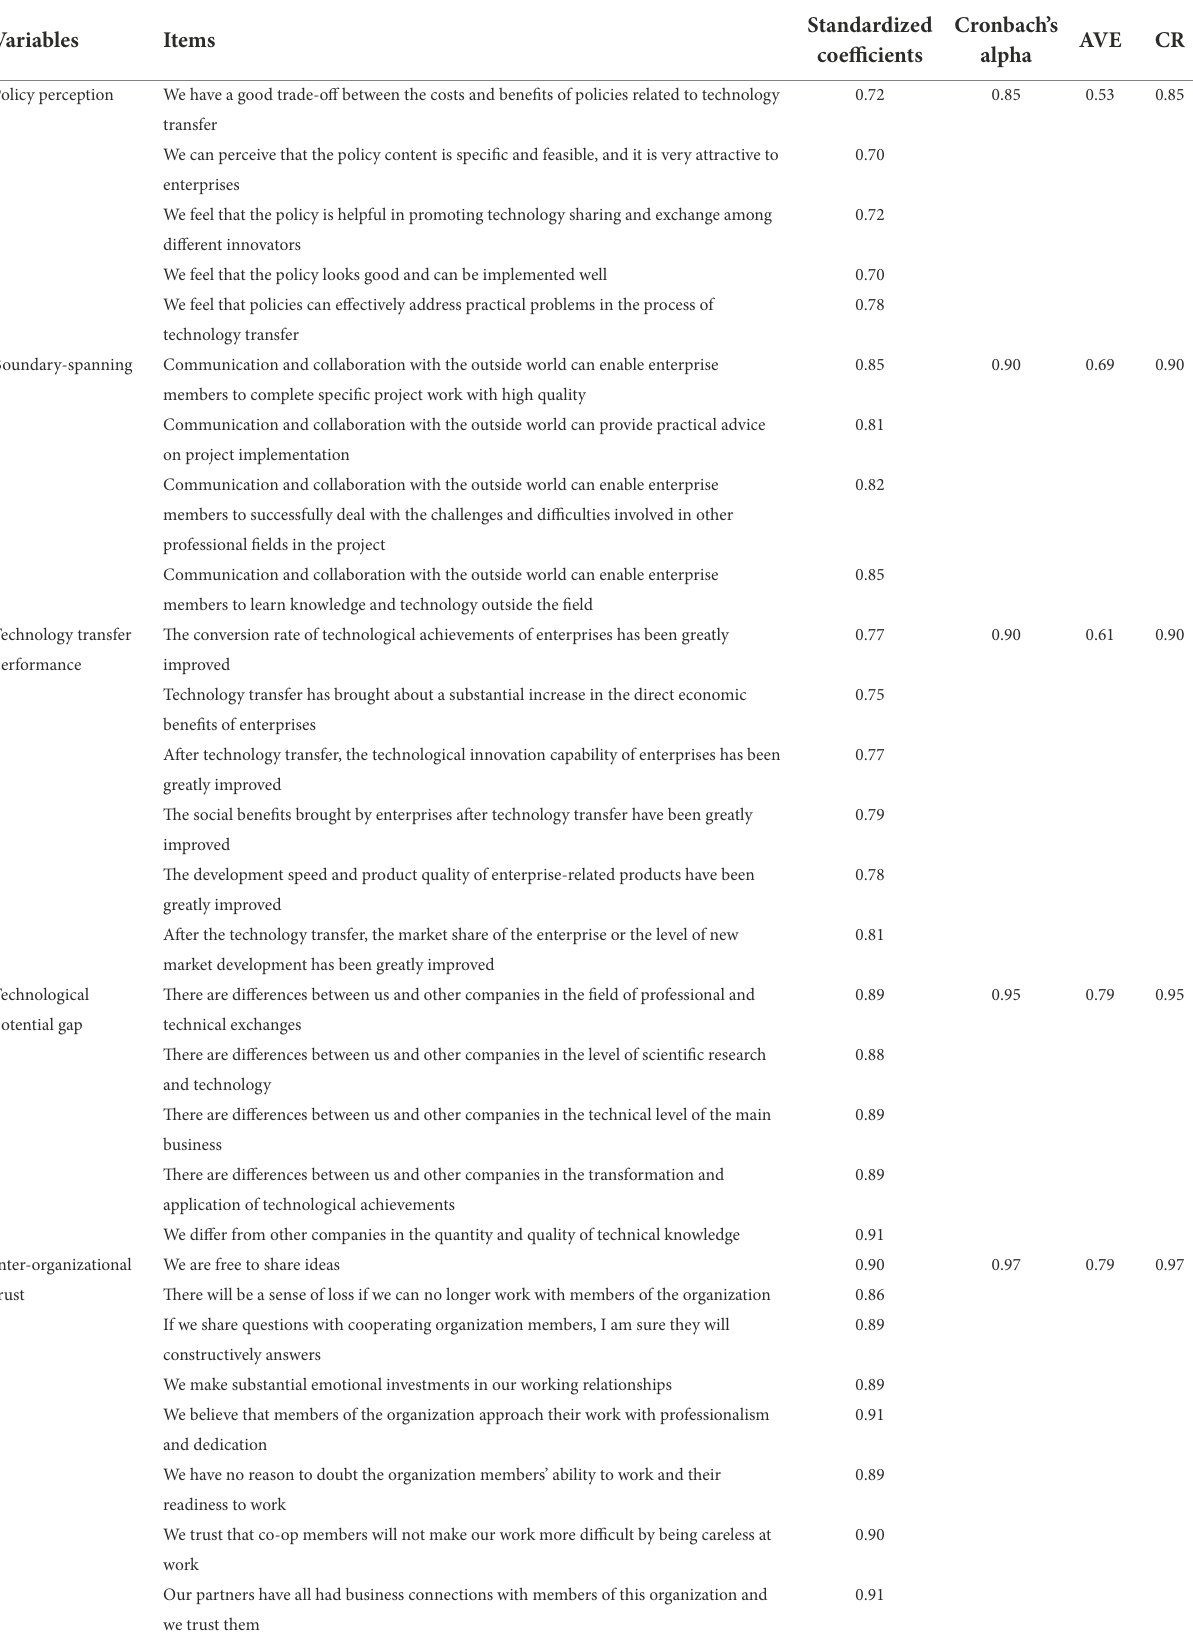
TABLE 3 Scale items, reliability, and validity